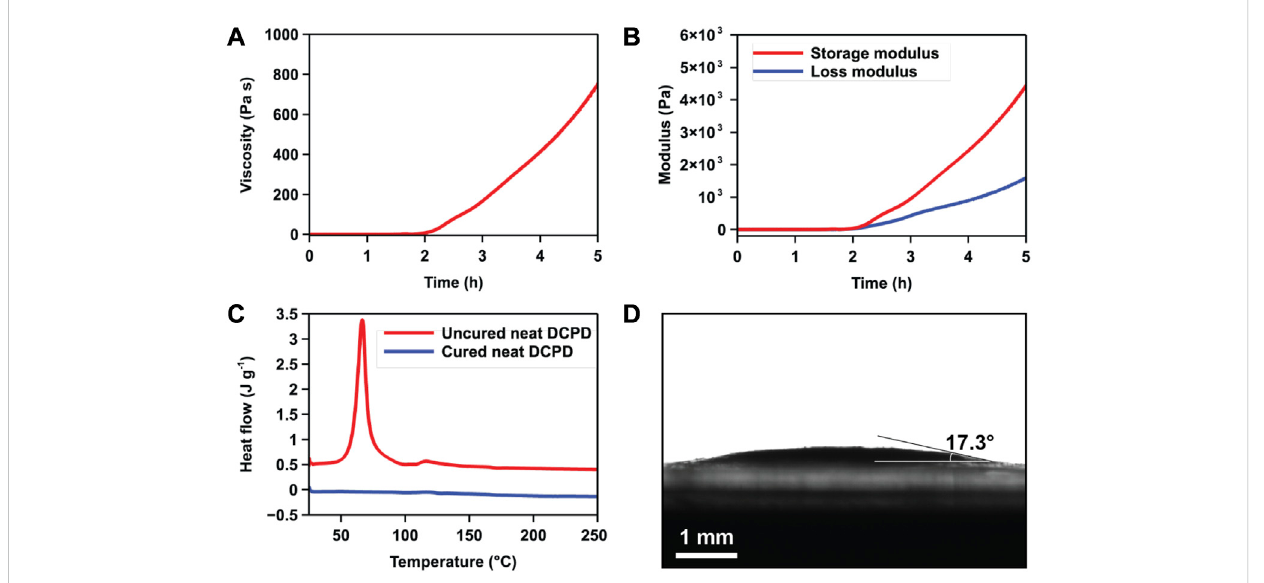
FIGURE 2 Characterization of DCPD resin system (A, B) Time-sweep viscosity and modulus pro fi les of an uncured DCPD resin containing 1 M equivalent of inhibitor with respect to Grubbs ’ catalyst at 23 ° C. (C) Thermal pro fi le of an uncured resin sample and a pDCPD fi lm sample cured at 100 ° C for 5 min. (D) Contact angle measurement for a droplet of DCPD resin on the buckypaper substrate.